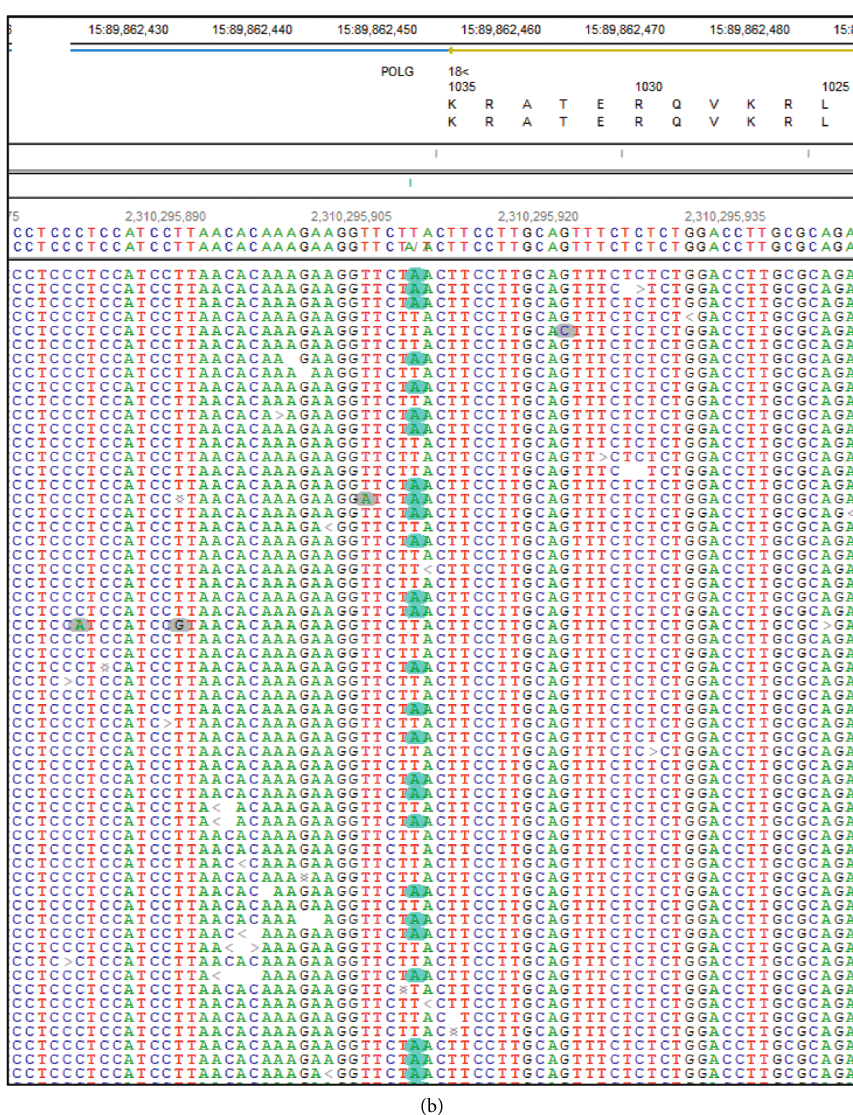
Figure 1: Whole exome sequencing demonstrates compound heterozygous variants in POLG. Pile-ups of sequencing reads show (a) a heterozygous deletion of 22 base pairs in exon 2, c.67_88del, resulting in p.(Gly23Serfs ∗ 236) and (b) a heterozygous point mutation in intron 19, c.3104+3A > T, resulting in skipping of exon 19. The variants are highlighted in